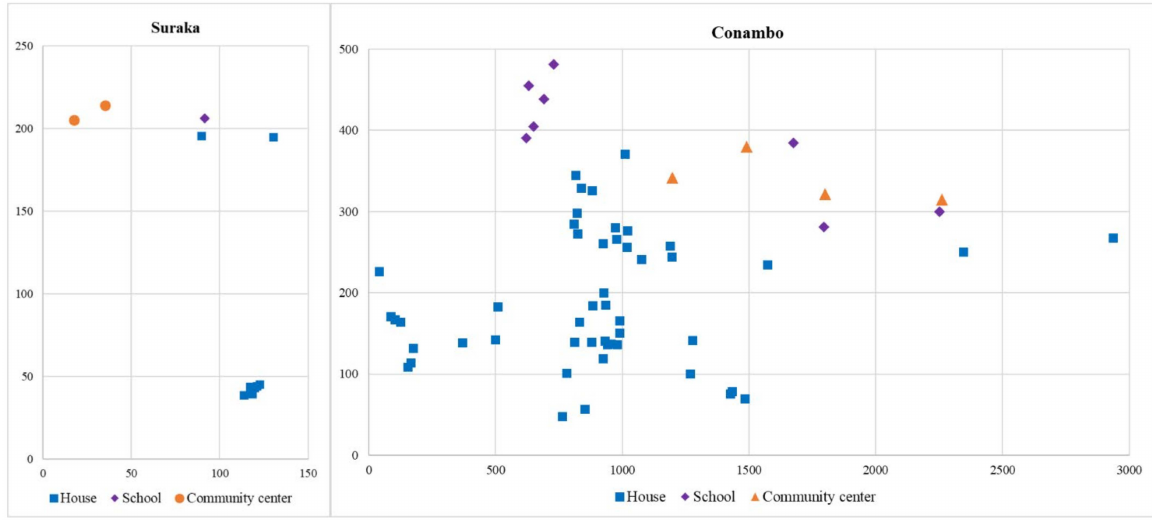
Figure 2. Layout of the Ecuadorian